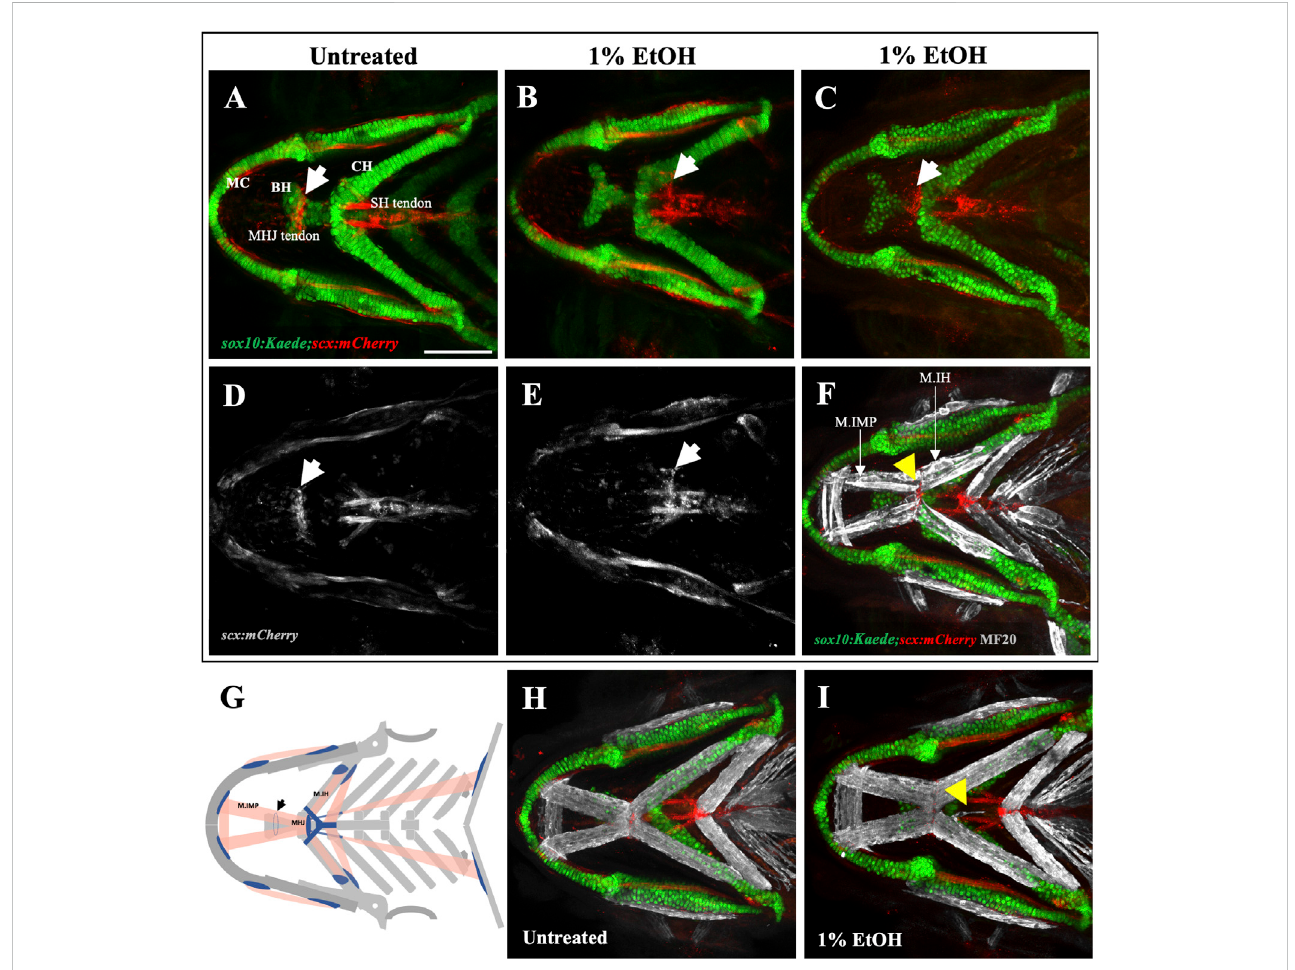
FIGURE 4 Ethanolcanmislocatemyotendinousattachmenttissues (A,D) Ventralviewofbranchialcartilageandtendoninuntreated sox10:Kaede;scx:mCherry fi sh at 4dpf. Arrows show the normal position of the MHJ (mylohyoid junction) around the anterior basihyal. (B,C, E) Posteriorized MHJ position in ethanol- exposed sox10:Kaede;scx:mCherry fi sh at the level of SHT (sternohyoideus tendon) in (B, E) and at the anterior end of ceratohyal in (C) (F) Ethanol-exposed sox10:Kaede;scx:mCherry fi sh immunostained with MF20 (gray), anti-Kaede (green) and anti-mCherry (red) antibodies. Arrow shows that the posterior end of the Intermandibularis posterior muscle (M.IMP) aligns with the MHJ tendon and is located at the level of ceratohyal. (G) Schematic showing posteriorized MHJ tendon and Intermandibularis posterior muscle (M.IMP). Arrow indicates the normal position of the MHJ tendon. (H, I) Untreated (H) and ethanol-exposed (I) sox10:Kaede;scx:mCherry fi sh immunolabeled with MF20 (gray), anti-Kaede (green) and anti-mCherry (red) antibodies. Arrow in I shows ectopic muscle fi ber without any effect on tendon pattern. Scale bar = 100